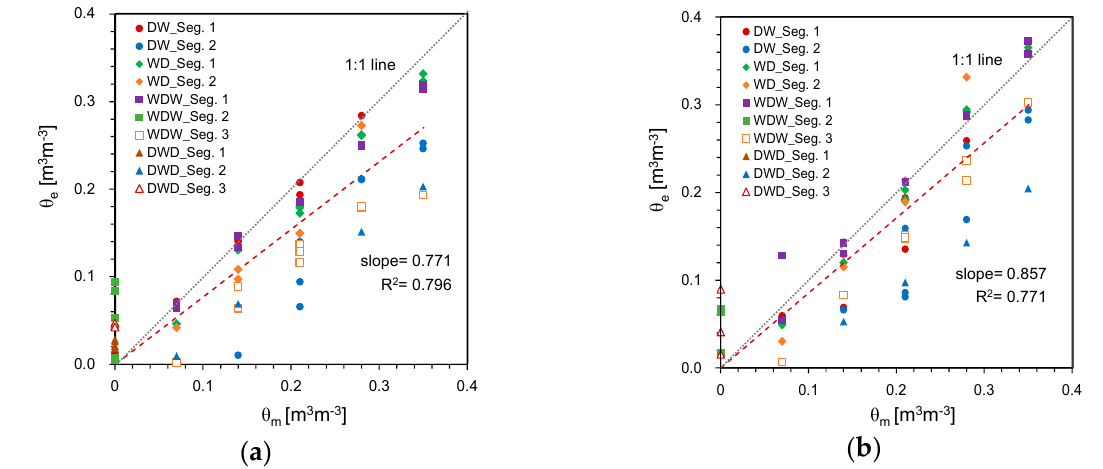
Figure 13. Comparison of SWCs measured and estimated with the probe lengths of: (a) 50 cm; (b) 100 cm. θ m and θ e denote the SWCs measured and estimated from HETDR, respectively. Table 4. Values of the slope of the linear relationship for SWCs measured and estimated at each segment.